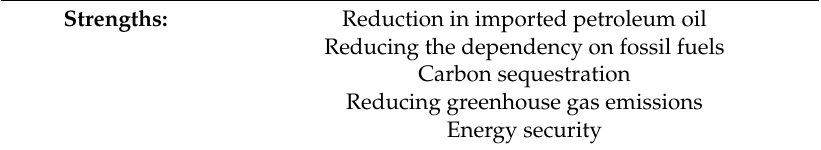
Table 4. Strengths, weaknesses, opportunities, and threats of biofuels in Sub-Saharan Africa.